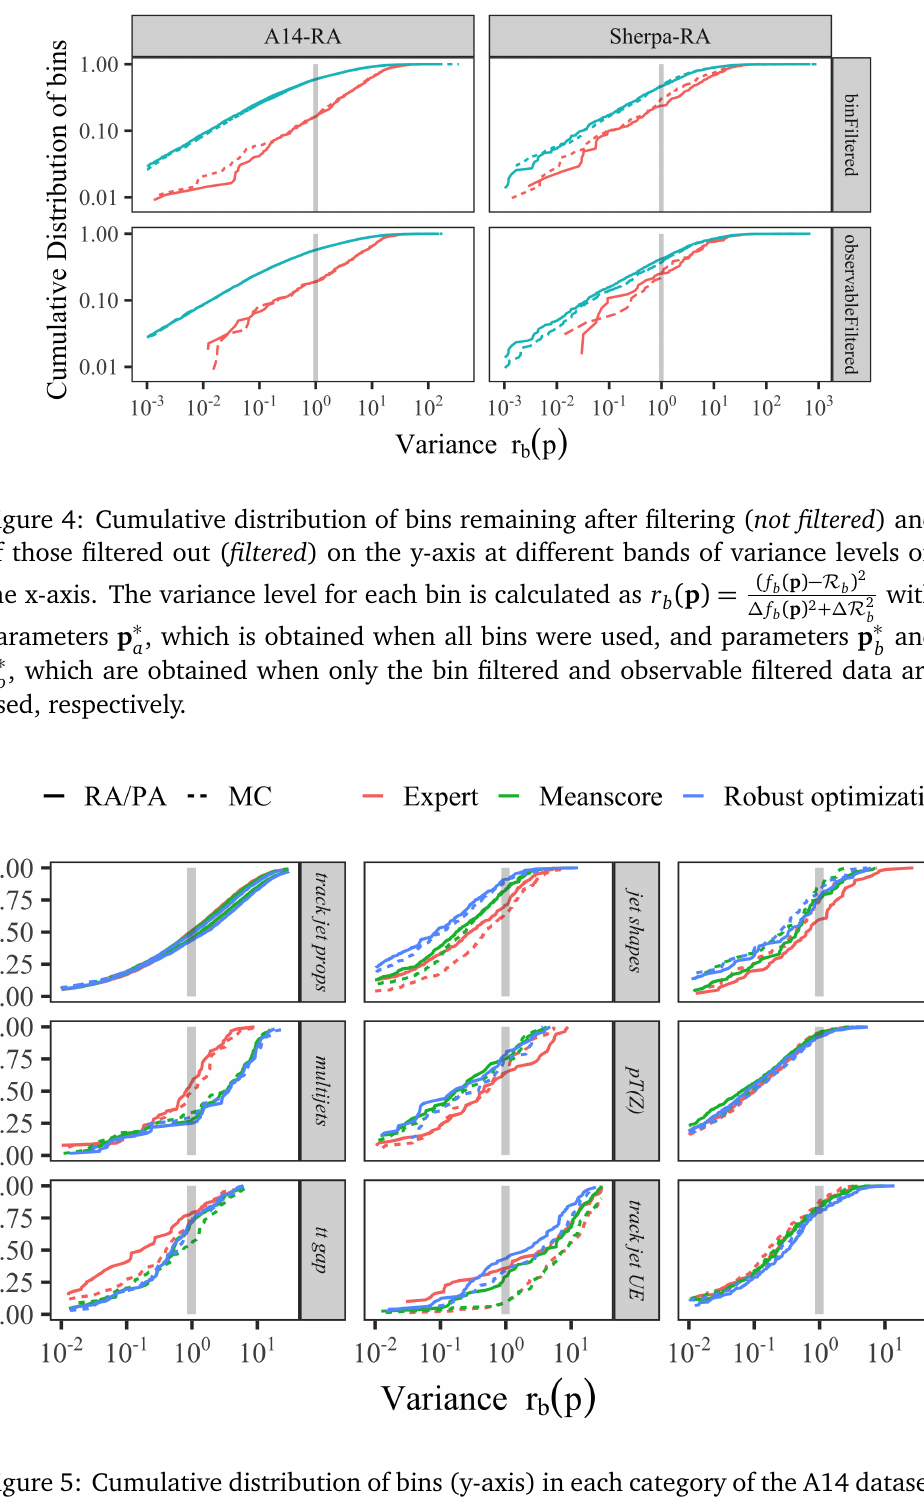
Figure 5: Cumulative distribution of bins (y-axis) in each category of the A14 dataset at different bands of variance levels (x-axis) computed with cubic polynomial approx- imation (PA) or rational approximation (RA) and the MC